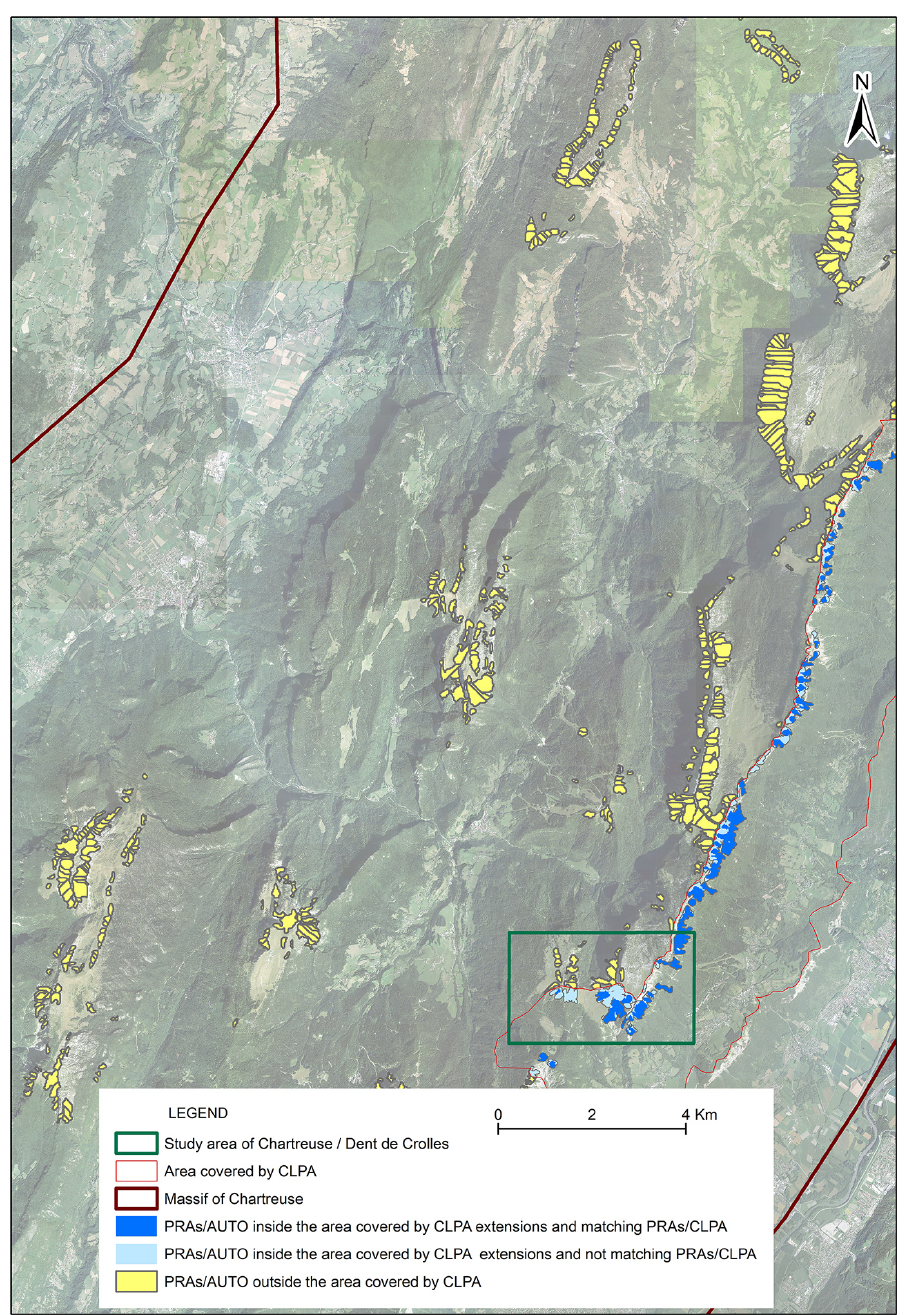
Figure 6. Result of the proposed PRA detection method for the entire Chartreuse massif. For the PRA detection and the determination of the validation sample, all factors and the DEM resolution are set to their default values (Figs. 3–4) and forest cover data are from DB forest IGN. “CLPA extensions” refer to avalanche extents from the French avalanche cadastre. Aerial photograph © IGN 2012.